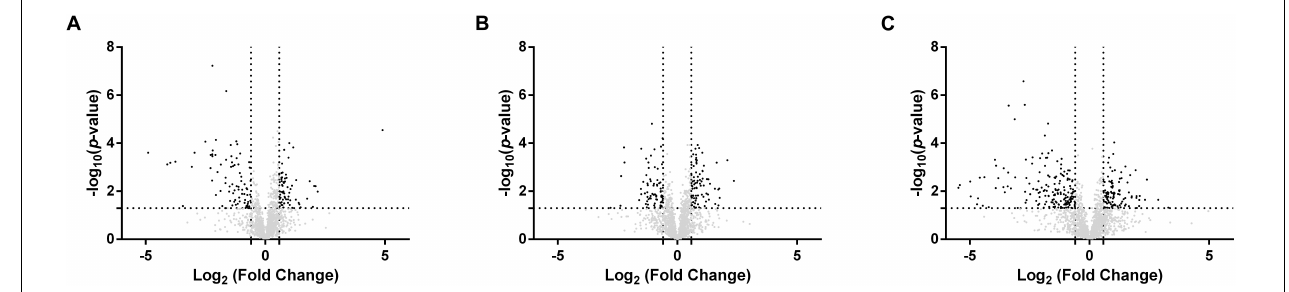
FIGURE 3 | Volcano plots of the proteins quantified with significantly differential abundance between sample harvested before or after the light stress. The –log 10 ( p -value) is plotted against the log 2 (fold change). The non-axial vertical lines denotes ± 1.5-fold change (prior to logarithmic transformation) while the non-axial horizontal line denotes p = 0.05, which is our significance threshold (prior to logarithmic transformation). (A) Wild-type strain cultivated with succinate (post